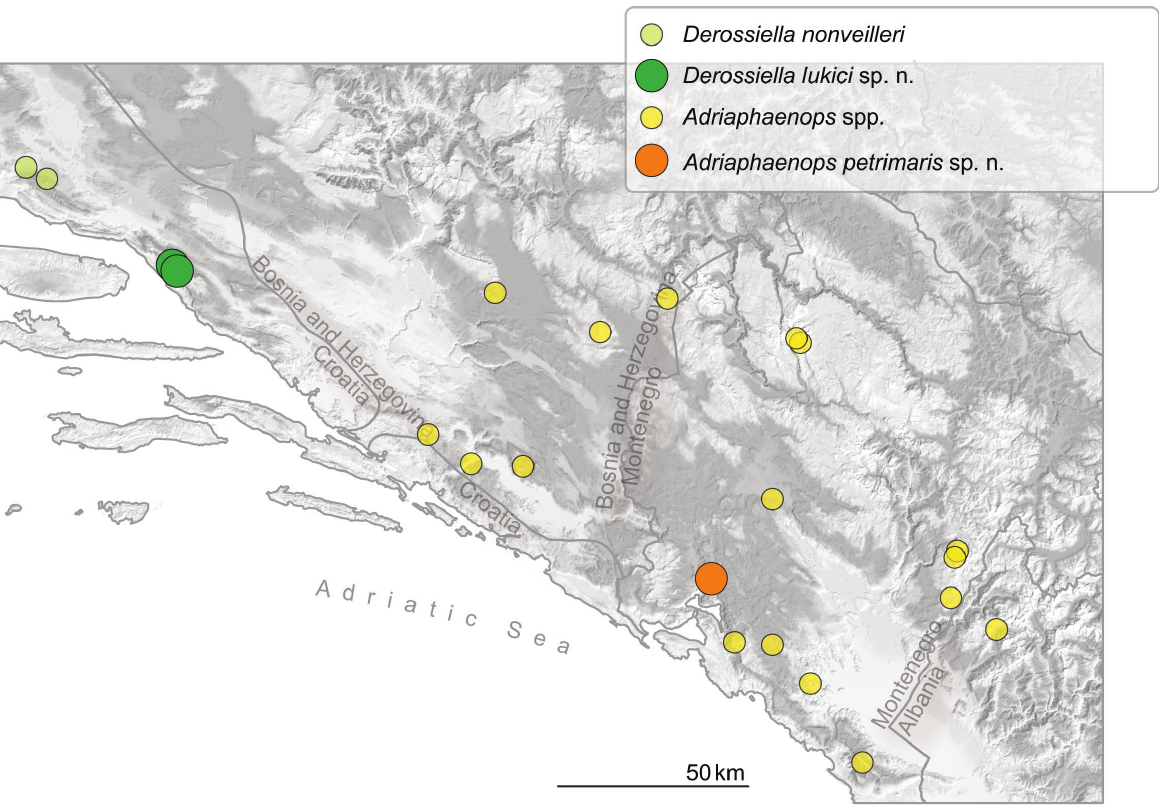
Figure 2. Geographical distribution of the Dinaric aphaenopsoid trechines of the genera Derossiella and Adriaphenops . Source of data: